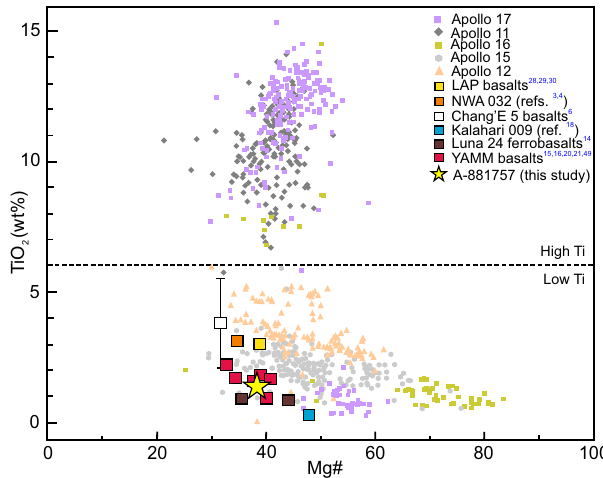
Fig. 1 | Bulk major-element composition comparison among A-881757, YAMM andotherlunarbasalts. TiO 2 plottedagainstbulkMg#(molarMg/(Mg+Fe)×100), showing YAMM basalts are the low-Ti and most Fe-rich variety. Compositions of Apollo basalts are taken from the ApolloBasalt DB(v2) database 72